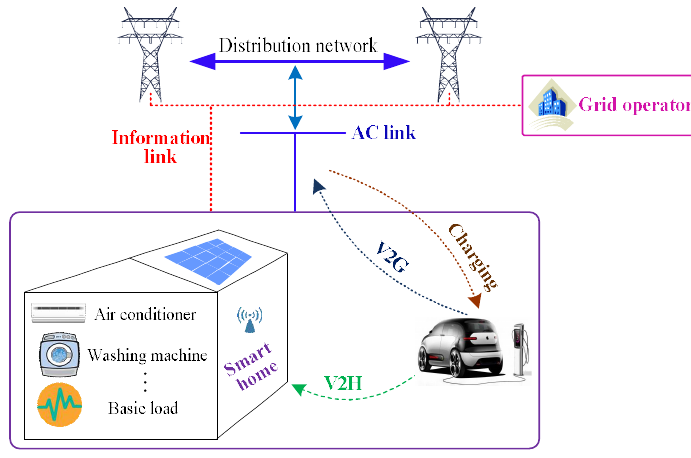
Figure 2. Paradigm of V2H.